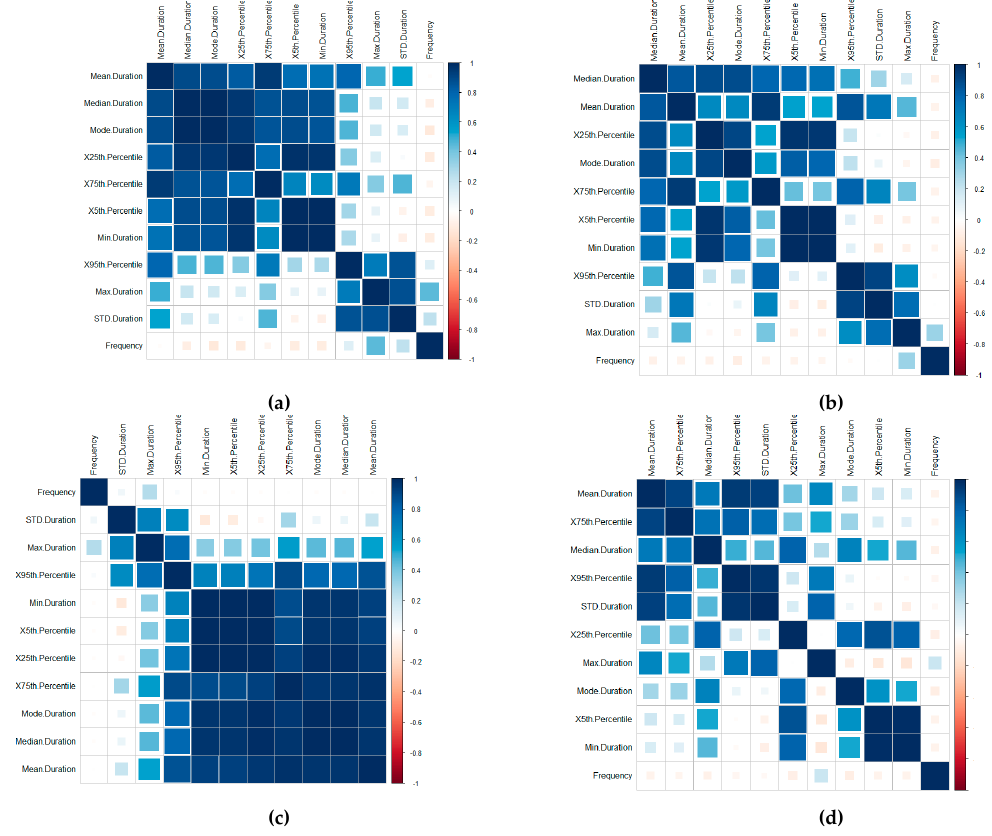
Figure 4. ( a ) Device, ( b ) Patient, ( c ) Routine, ( d ) User.